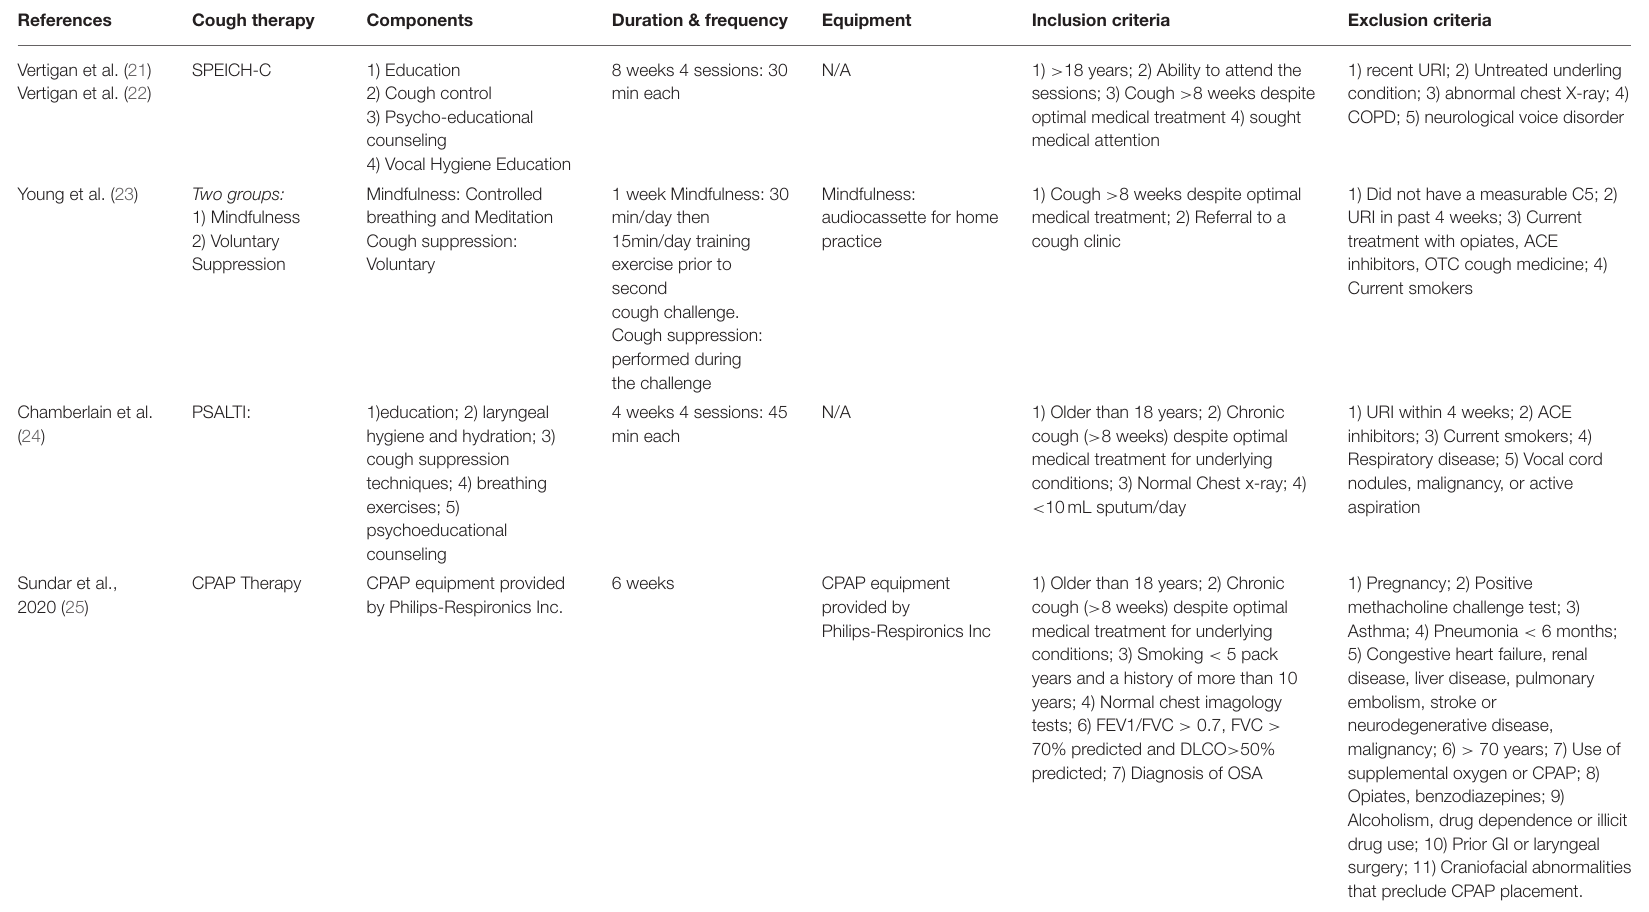
TABLE 2 | Intervention